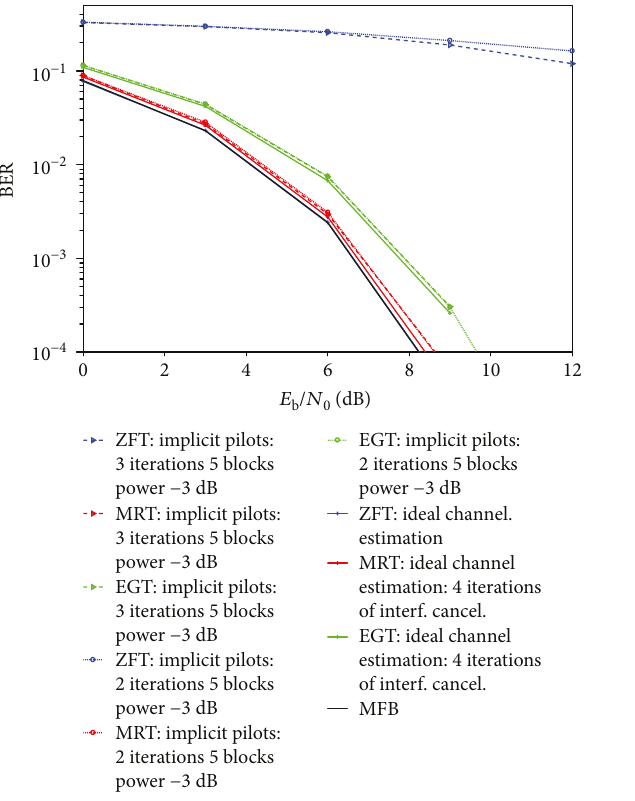
Figure 10: BER results with 32 × 2 using implicit pilots with 5 versus 15 data blocks, 3 iterations, and a pilot power of 0